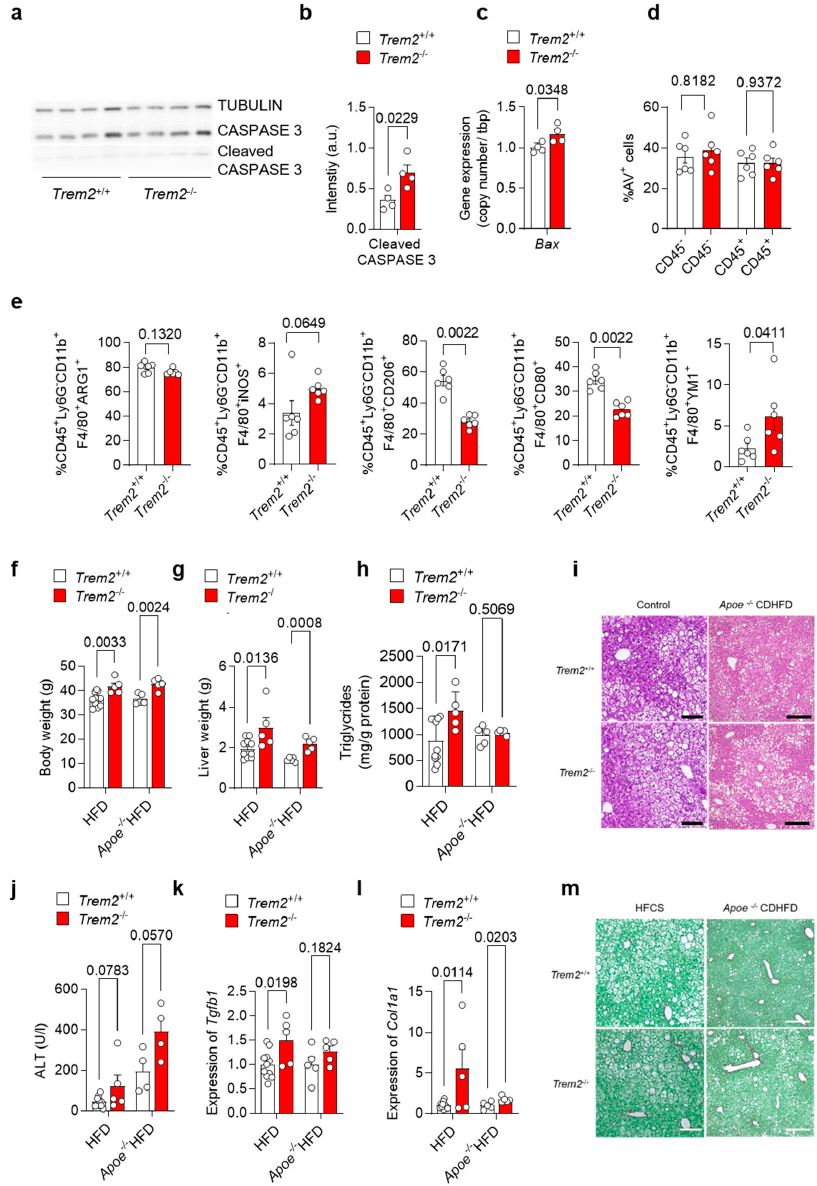
Trem2 − / − macrophages compared to controls (Figure 4e).